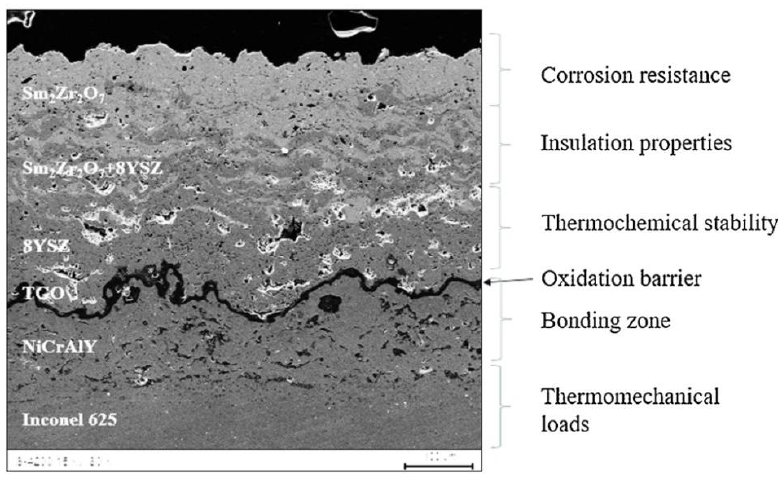
Figure 11. FE-SEM images show the functional zones of the FGC technique [47].